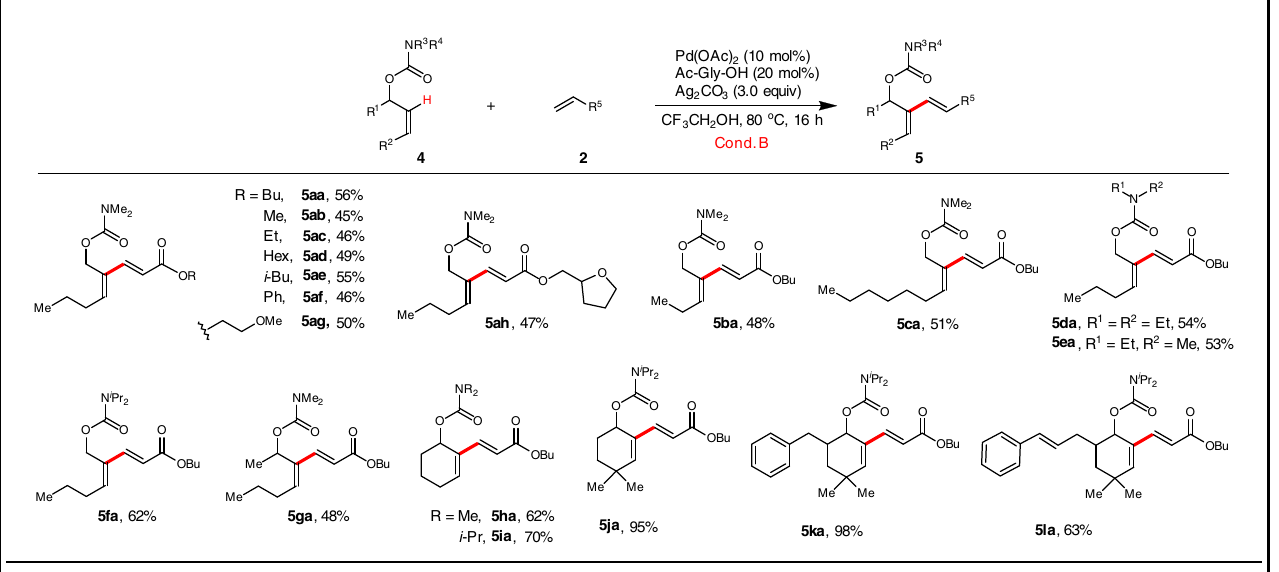
a The yields are isolated yields based on carbamate 4